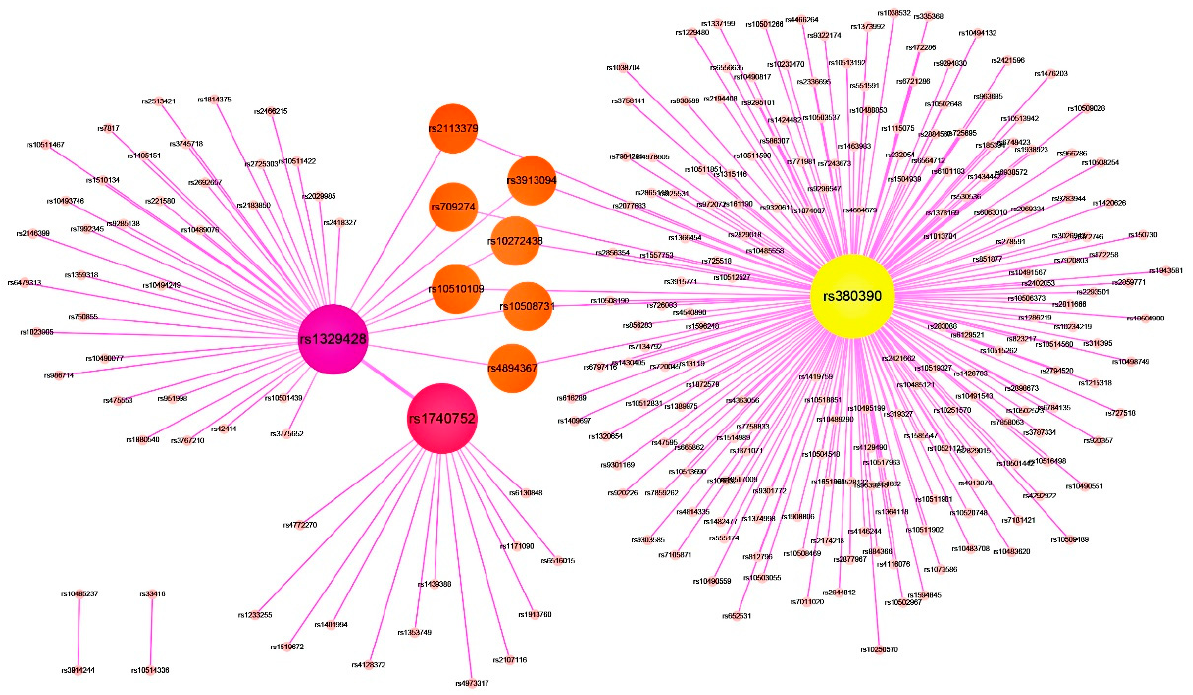
Figure 8. Epistasis network of AMD.